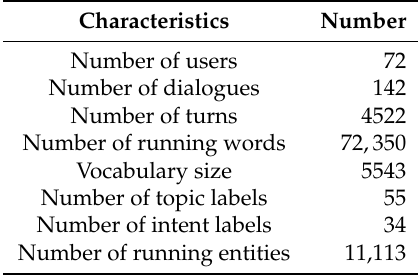
Table 2. Description of the annotated corpus.